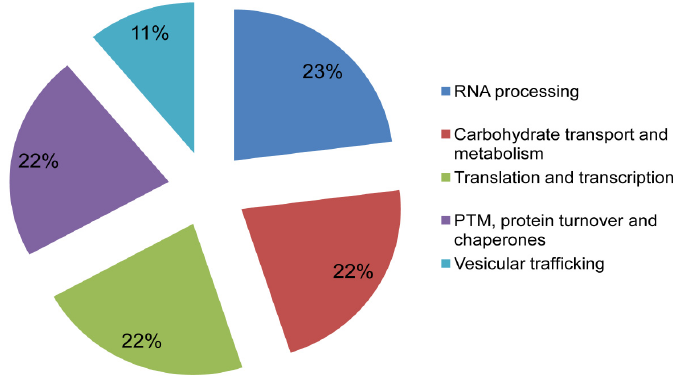
Figure 5. Functional annotation of newly identified mTORC1 interacting proteins. Putative biological functions of the identified proteins were assigned by using online functional annotation